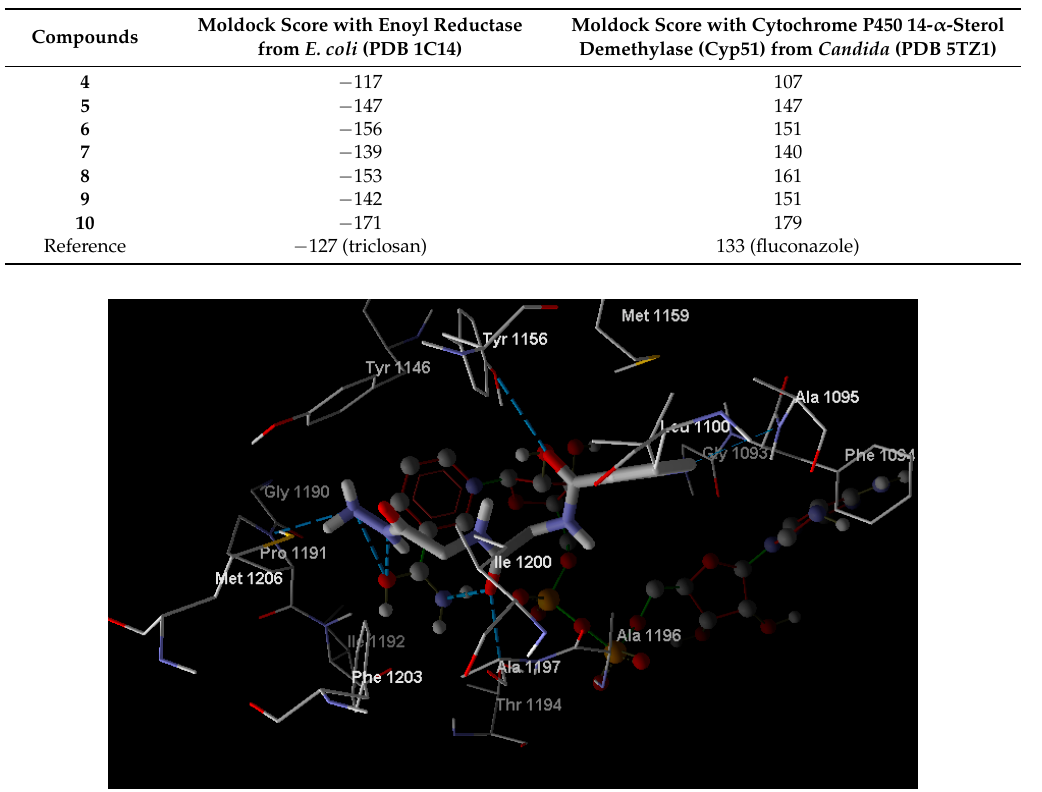
Figure 2. A binding mode of 4 into the binding site of enoyl reductase ( Red: Oxygen, Blue: Nitrogen, Gray: Carbon, Dash line: Hydroegen bonds).